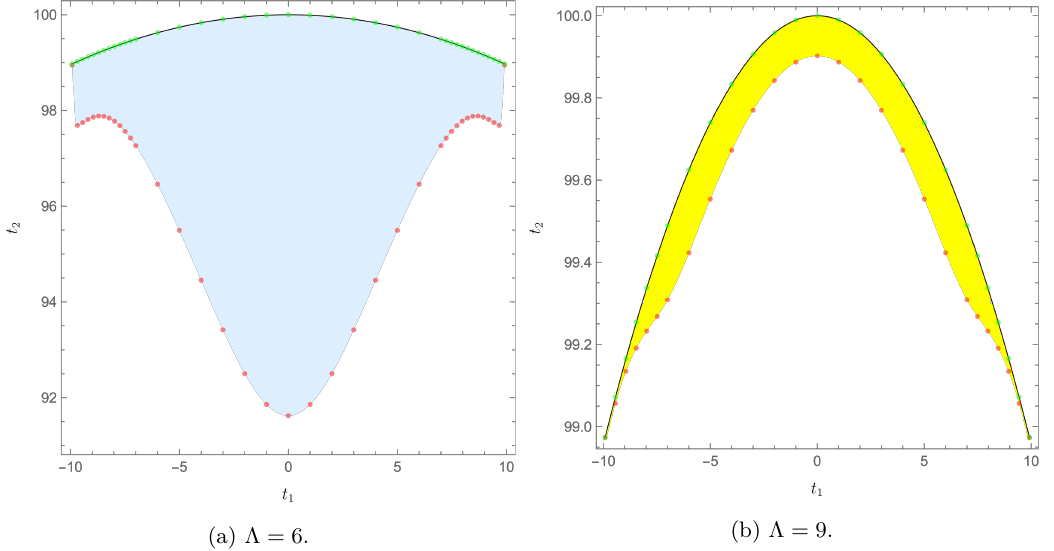
Figure 10 . The allowed t 1 − t 2 region for Λ = 6 and Λ = 9 . The corresponding parameters in the model (5.24) are g = 1 , h = 0 . The shaded region is the result of one-matrix bootstrap. The 100 black line is the exact analytic solution described in section 3.2. The green and red dots are the upper bounds and lower bounds of our relaxation method from scanning over t 1